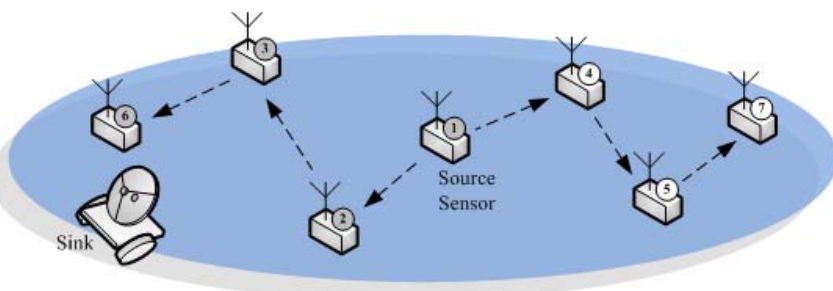
Figure 8. The network topology in the